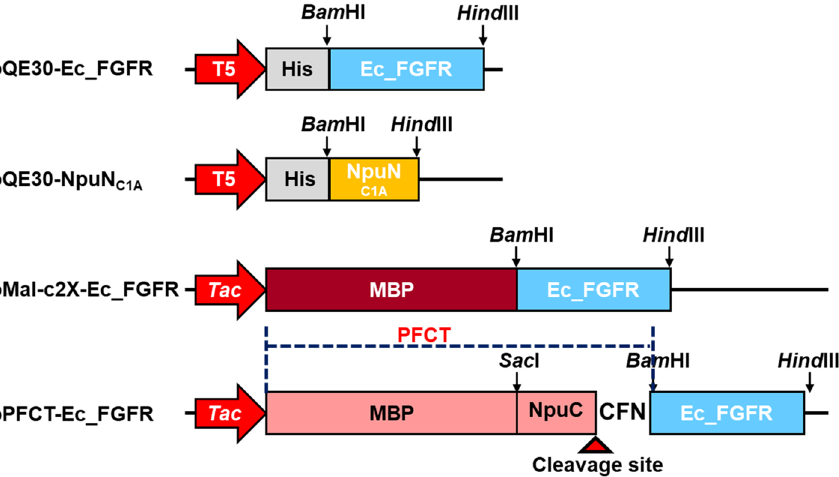
Figure 1. Recombinant DNA constructs used for the expression of protein of interest (POI) and protease-free cleavable tag (PFCT). In PFCT, NpuC consisted of 38 amino acids , including three additional residues CFN (+ 1 to + 3) of natural extein sequence. Therefore, three amino acids were additionally fused to the N-terminus of Ec_FGFRs after intein-mediated cleavage